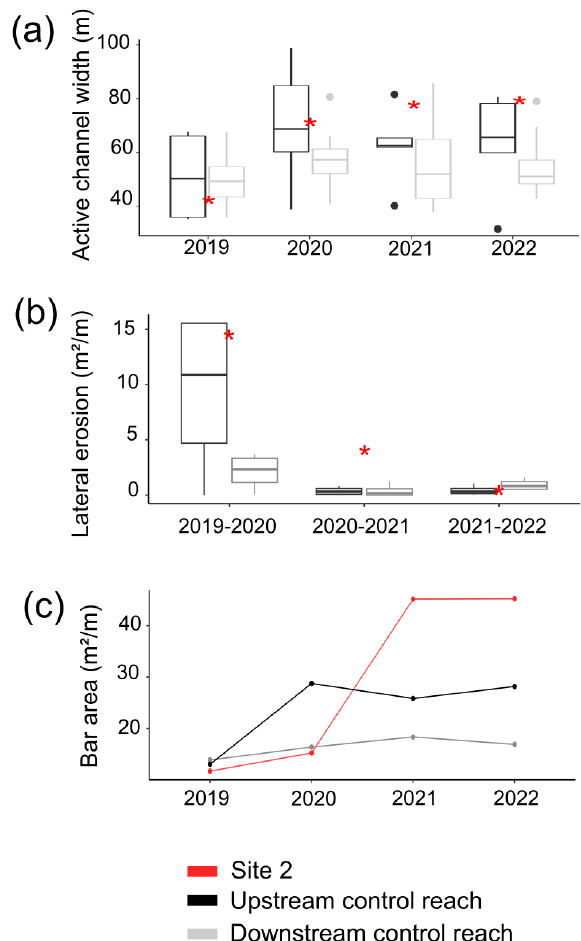
Figure 7. Evolution of planform indices and comparison of ( a ) active channel width (m), ( b ) bank erosion (m 2 /m), and ( c ) bar area (m 2 /m). The red asterisk (star) represents ( a ) the value of the channel width and ( b ) lateral erosion recorded at the restored bank, whereas the other values were recorded at the upstream and downstream control reaches. Riprap on site was removed in September 2019.